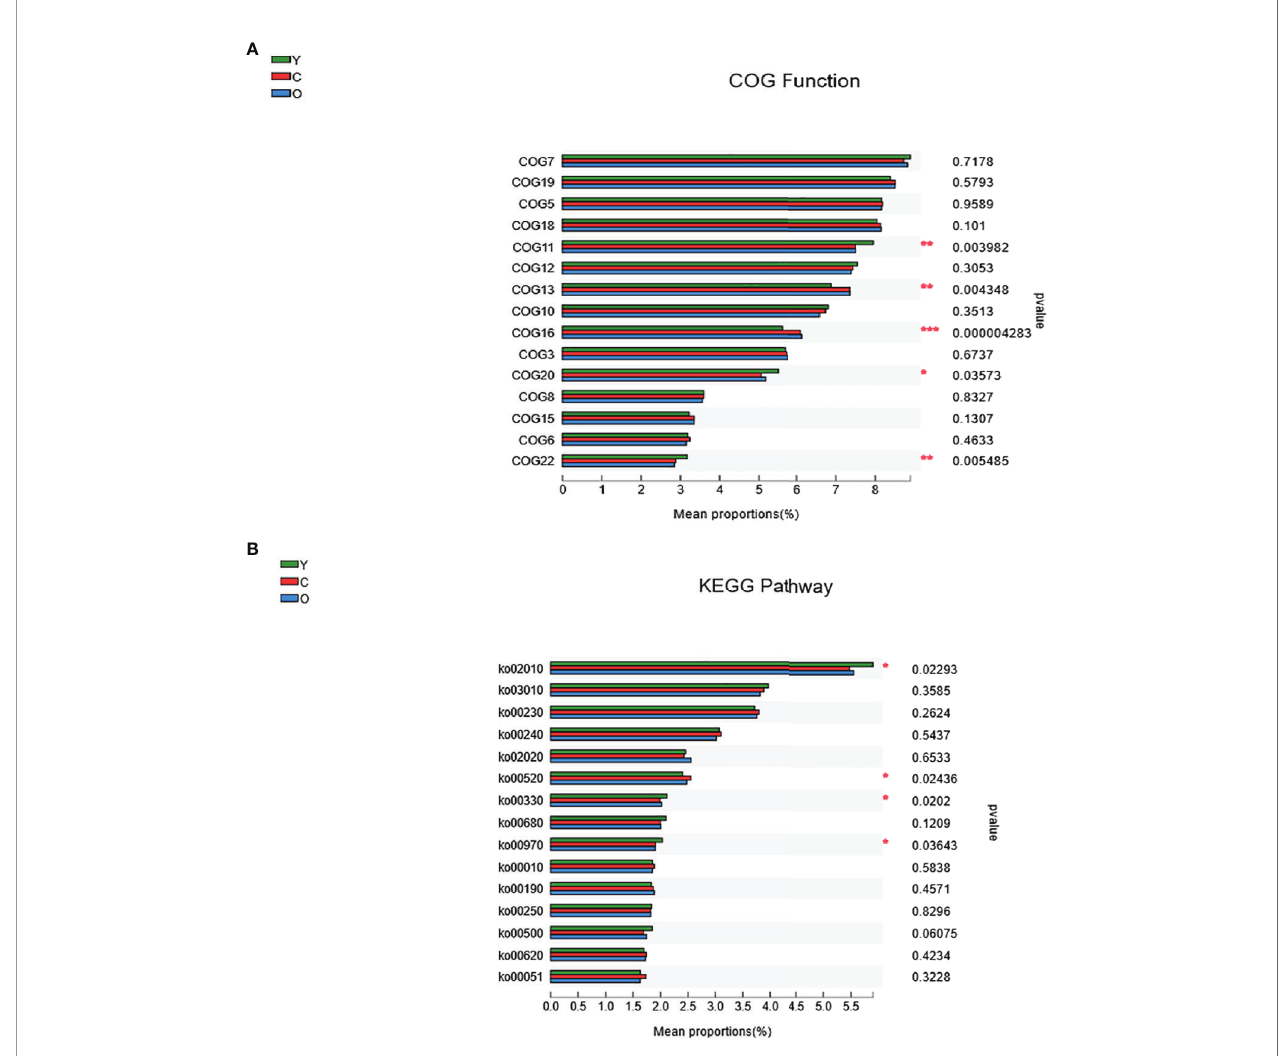
FIGURE 5 | The function prediction of the three groups. (A) The differences of Cluster of Ortholog Genes (COG) function. (B) The abundance differences of the Kyoto Encyclopedia of Genes and Genomes (KEGG) pathway. (0.01 < P ≤ 0.05 marked as *, 0.001 < P ≤ 0.01 marked as ** P ≤ 0.001 marked as***). (Y, young volunteers; O, old volunteers; C, CRC